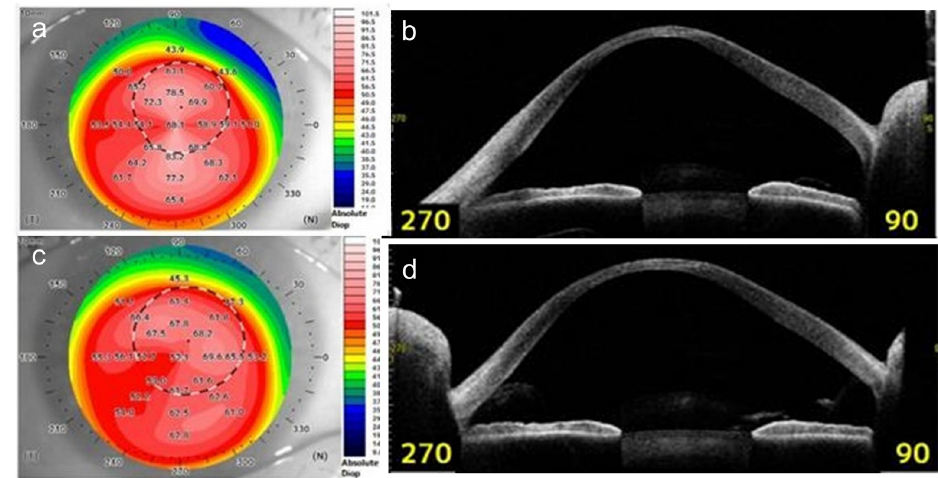
Fig 1. Representative corneal topographic maps and tomographic images of a patient with keratoconus. The maps and images were before and after using a rigid gas-permeable contact (RGP) lens. (A) Corneal topographic map before using the RGP lens. (B) Tomographic image of the cornea with anterior segment optical coherence tomography before using the RGP lens. (C) Corneal topographic map after using the RGP lens. The keratometric values appear to have decreased after RGP lens use compared with those before RGP lens use. (D) Tomographic image of the cornea with anterior segment optical coherence tomography after using the RGP lens. Corneal protrusion appears to have decreased after RGP lens use compared with that before RGP lens use.